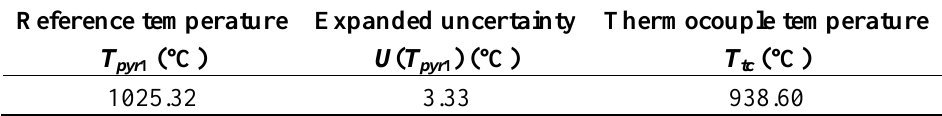
Table 5. Results of the